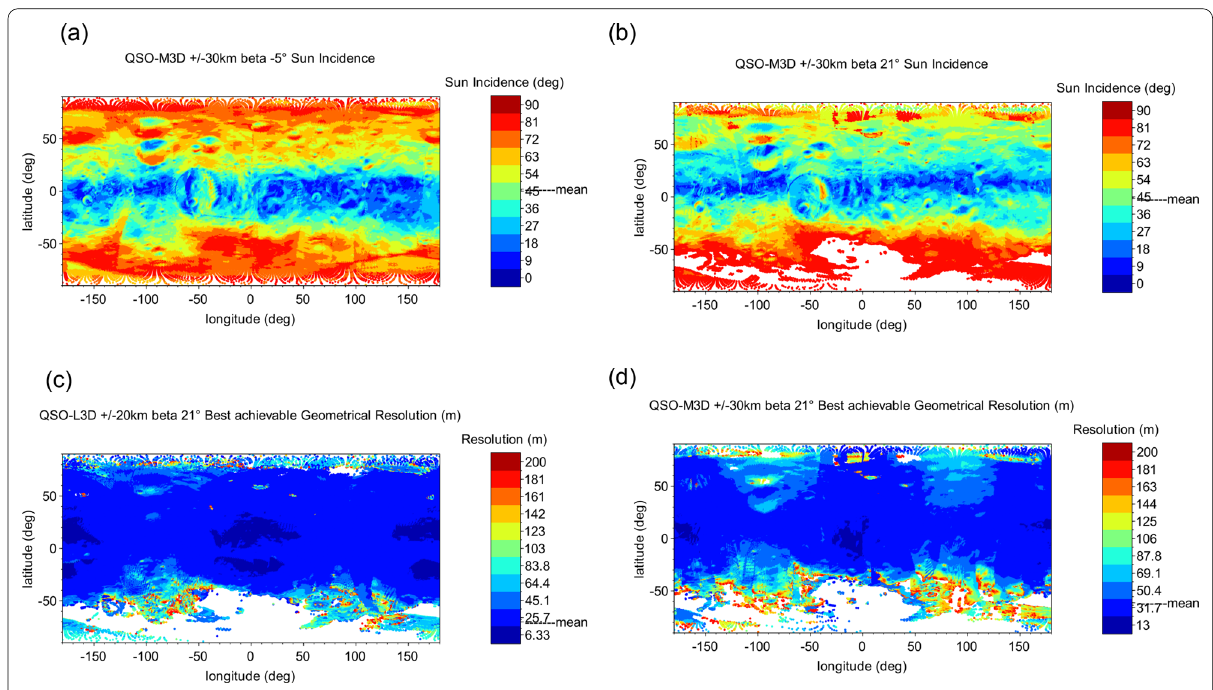
Fig. 12 Sun incidence angle distribution of a 3D‑QSO with z 30 km and β 5° and b 3D‑QSO with z 30 km and β 21°. In a both poles = ± = − = ± = can be observed with high Sun incidence angles, while in b Sun incidence is lower on North pole but most of south pole cannot be observed. c Geometric (spatial) resolution distribution of 3D‑QSO with z 20 km and β 21°. Percentage of surface covered at resolution better than = ± = 100 m is 58% for areas within 30° latitudes and 90% for all areas, at resolution better than 40 m is 47% for areas within 30° latitudes and 83% ± ± for all areas, at resolution better than 30 m is 43% for areas within 30° latitudes and 79% for all areas, at resolution better than 20 m is 32% for ± areas within 30° latitudes and 69% for all areas, and at resolution better than 10 m is 4% for areas within 30° latitudes and 23% for all areas. d ± ± Geometric (spatial) resolution distribution of 3D‑QSO wit z 30 km and β 21°. Percentage of surface covered at resolution better than 100 m is = ± = 52% for areas within 30° latitudes and 86% for all areas, at resolution better than 40 m is 31% for areas within 30° latitudes and 69% for all areas, ± ± at resolution better than 30 m is 21% for areas within 30° latitudes and 54% for all areas, at resolution better than 20 m is 6% for areas within 30° ± ± latitudes and 24% for all areas, and at resolution better than 10 m is 0% for areas within 30° latitudes and 0% for all areas. Areas in white cannot be ± observed because of spacecraft equatorial trajectory and Phobos flat shape on South pole. Areas with resolution above 200 m are not